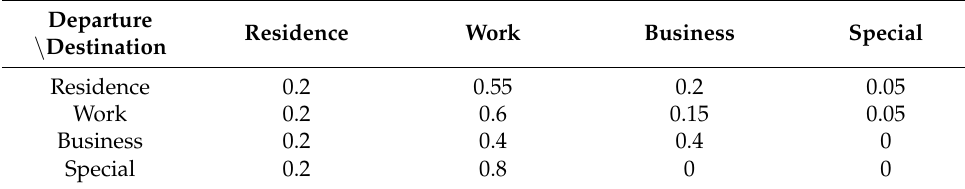
Table A1. OD matrix at 7:00~17:00 on weekdays.